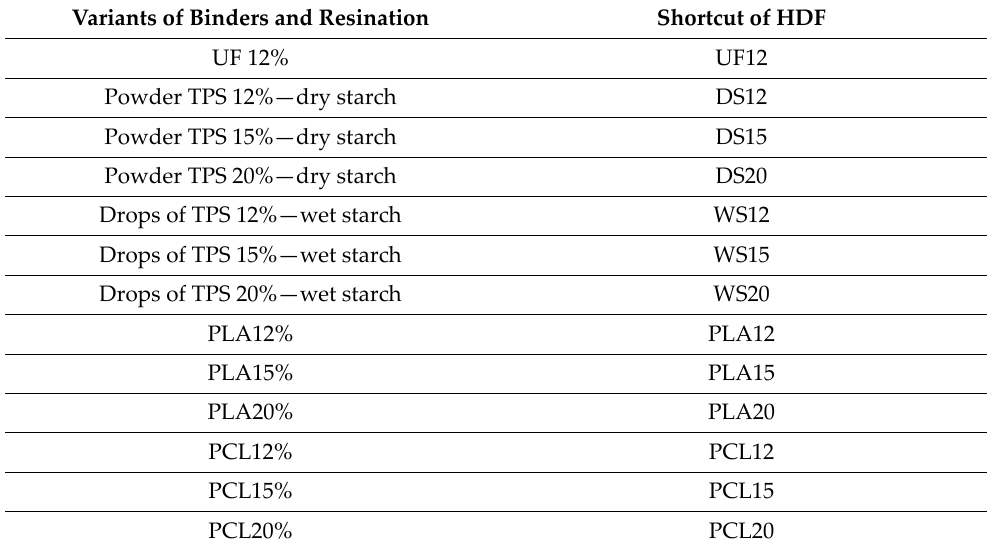
Table 1. Shortcuts for every elaborated HDF. Variants of Binders and Resination Shortcut of HDF UF 12%